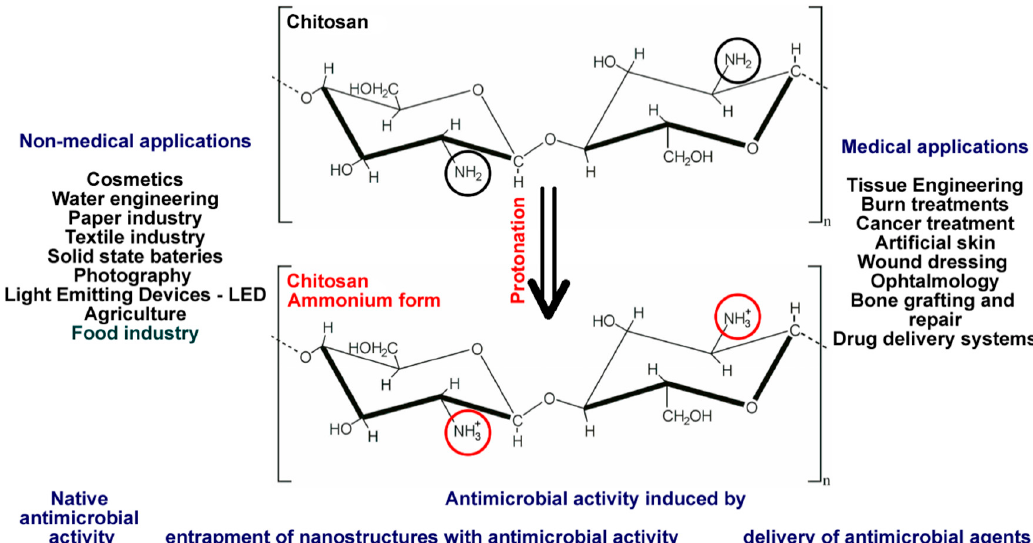
Figure 1. Chitosan protonation and its derived applications.